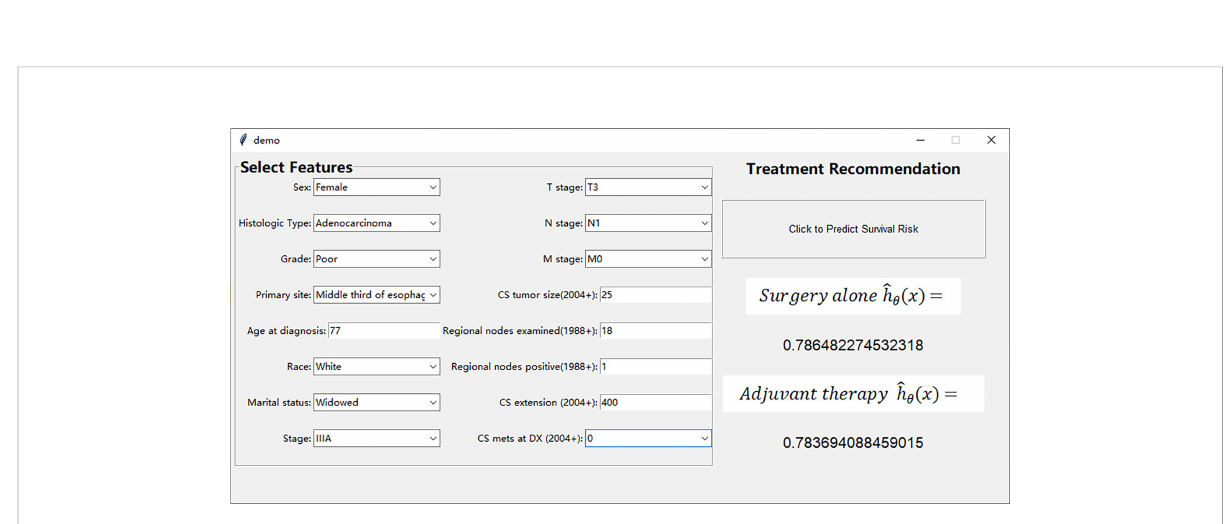
FIGURE 5 User interface to display the treatment recommendations provided by the DeepSurv